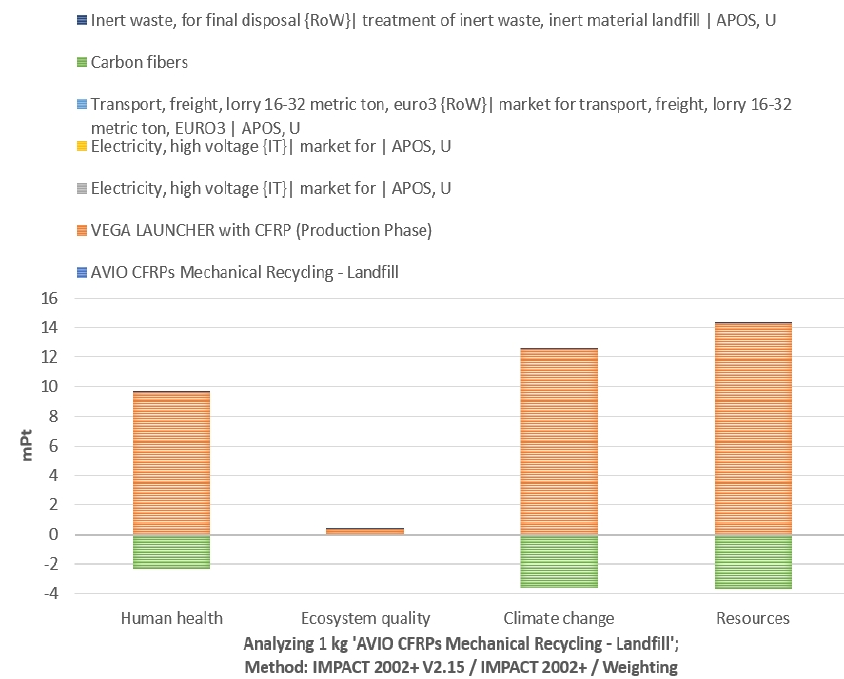
Figure 14. Results of mechanical recycling with landfill into endpoint categories.